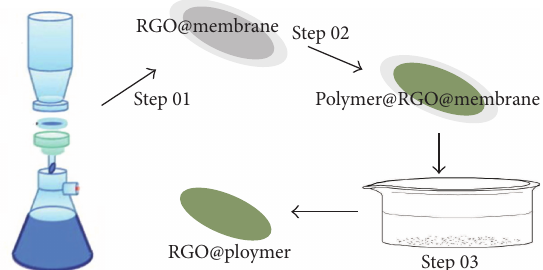
Figure 1: Schematic diagram of the preparation of RGO@polymer composite